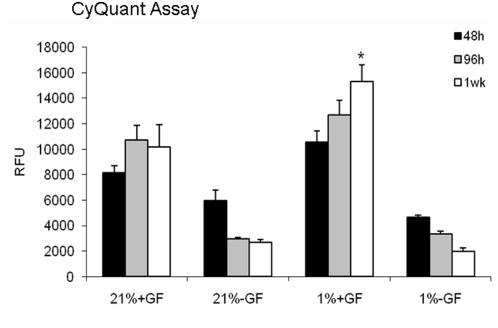
Hypoxia influences on cell number.CyQuant analysis was performed at 48 hrs, 96 hrs, and at 7 days for OLs cultured in the presence or absence of GFs in 21%2 or 1% O2. Relative florescence units are shown (RFU). In GF-treated cultures in 1% O2, levels was similar to the 21% O2 group at 46 and 96 hours (p>0.05; ANOVA). At 7 days, levels were greatest in the cells cultures in 1% O2 and GFs (*, p<0.05; ANOVA). Data are averages of three separate studies.